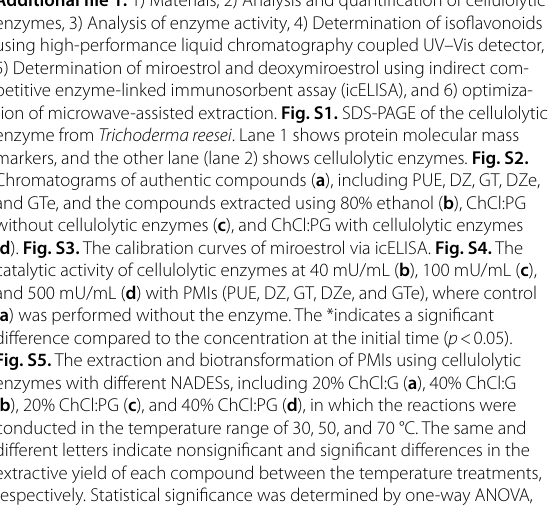
Table S9. The experimental design matrix of BBD and their results of daidzein ( Y 1 ) and genistein ( Y 2